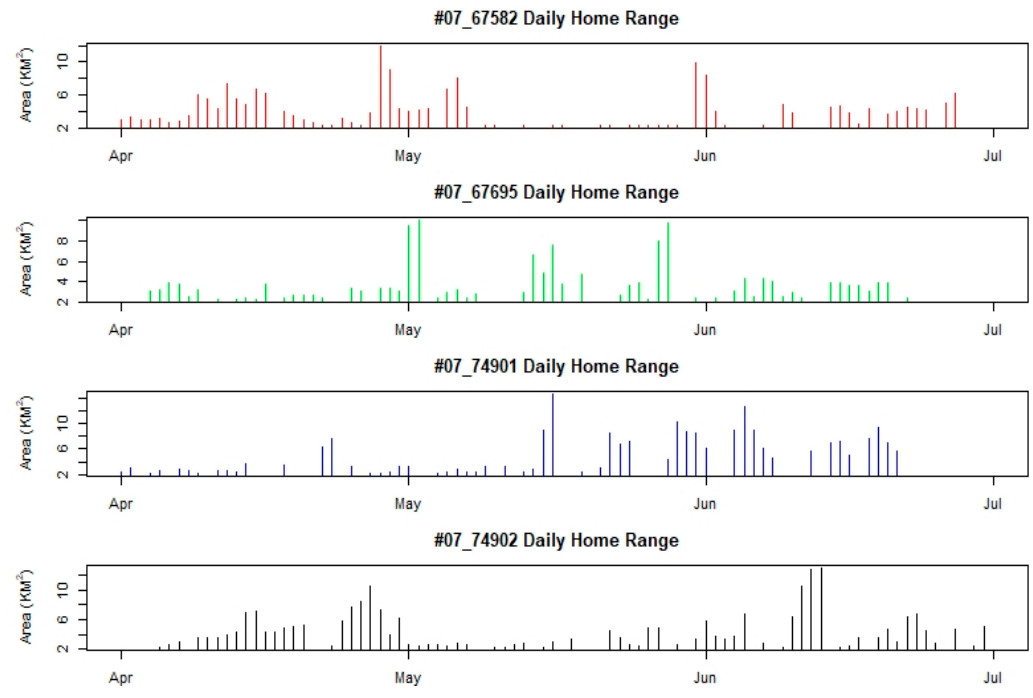
Figure 4. The dynamic change of daily home range sizes (km 2 ) of four Bar-headed Geese ( Anser indicus ) marked and satellite-telemetry tracked at Qinghai Lake in 2007. Birds 07_67582 and 07_74902 are female while 07_67695 and 07_74901 are male.